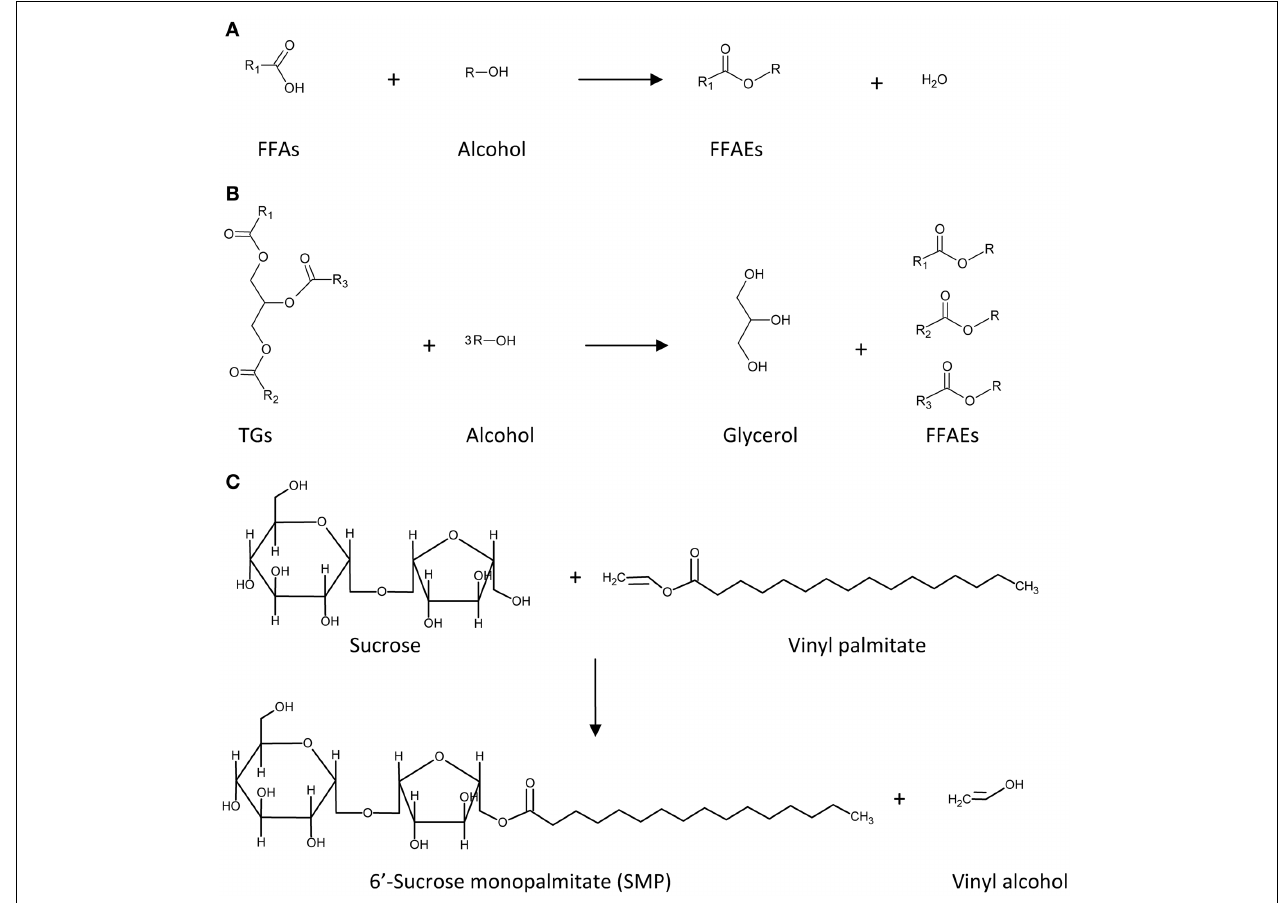
FIGURE 5 | Reactions of (trans)esterification catalyzed by CALB. Synthesis of biodiesel from (A) free fatty acids (FFAs) and (B) triglycerides (TGs). Synthesis of biosurfactant (C)